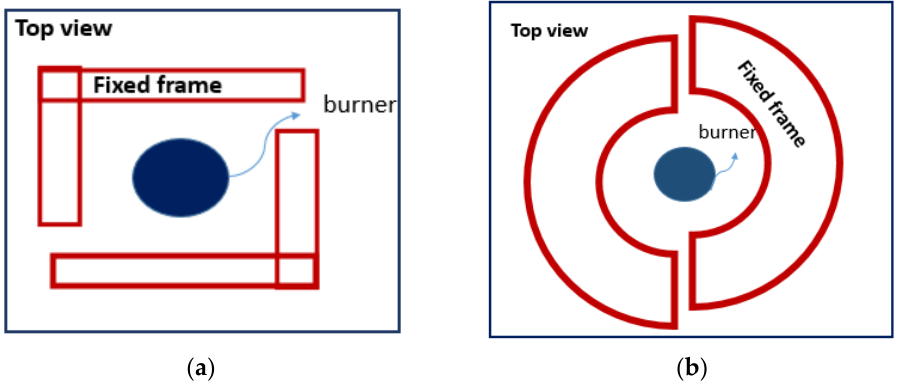
Figure 3. Fixed frames used in construction of fire whirls. ( a ) L-shaped covers; ( b ) cylinder halves.